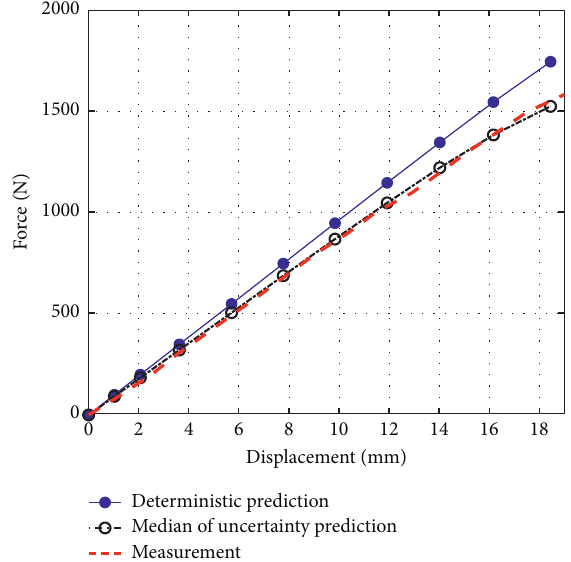
Figure 13: Comparison of the displacement-force curve: mea- surement, deterministic, and uncertainty